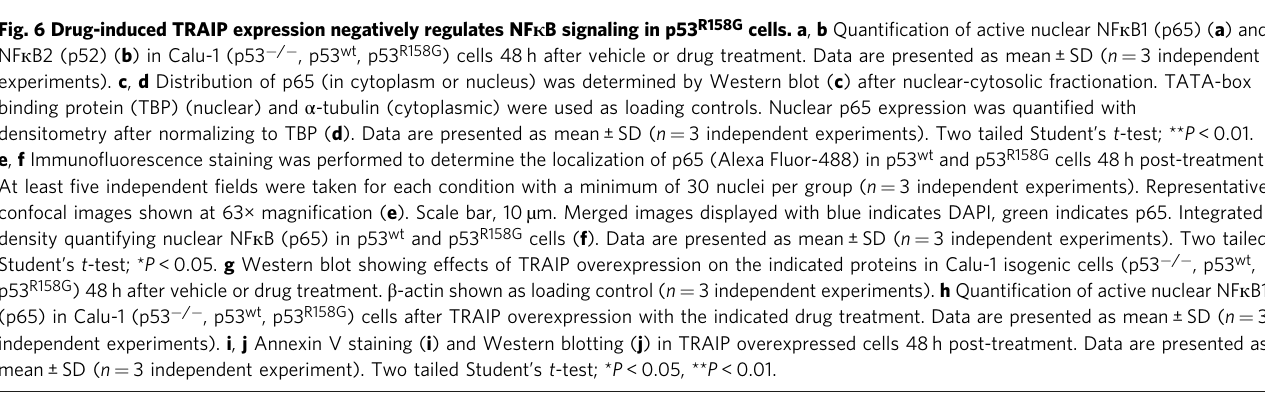
Fig. 6 Drug-induced TRAIP expression negatively regulates NF ĸ B signaling in p53 R158G cells. a , b Quanti fi cation of active nuclear NF ĸ B1 (p65) ( a ) and NF ĸ B2 (p52) ( b ) in Calu-1 (p53 − / − , p53 wt , p53 R158G ) cells 48 h after vehicle or drug treatment. Data are presented as mean ± SD ( n = 3